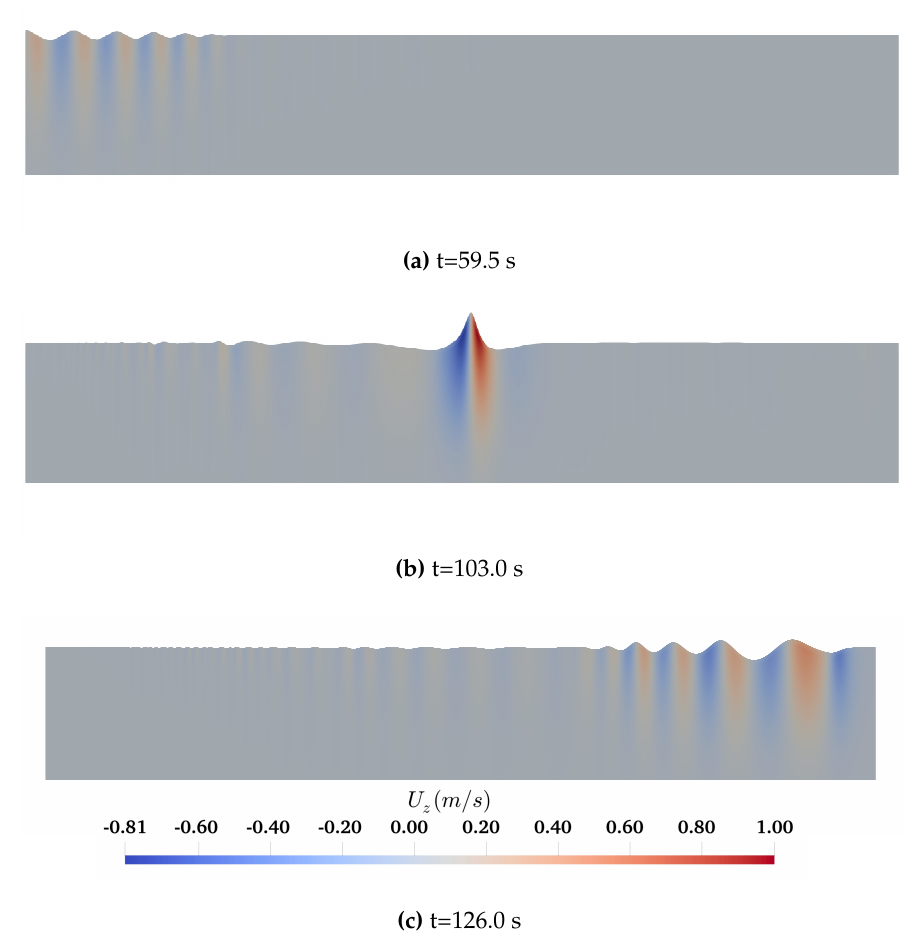
Figure 6. Vertical velocity component during the evolution of the focused wave group generated by the wave packet method, (a) t = 59.5 s, (b) t = 103.0 s, (c) t = 126.0 s. the wave packet method, ( a ) t = 59.5 s, ( b ) t = 103.0 s, ( c ) t = 126.0